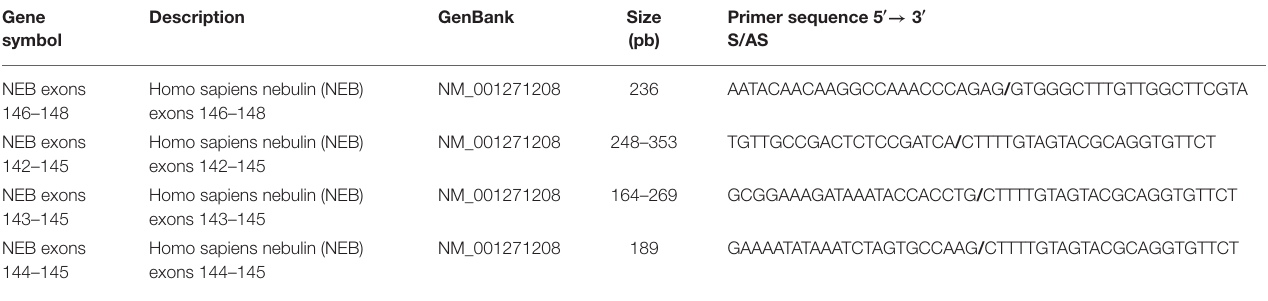
TABLE 1 | Primer sequences and gene description.